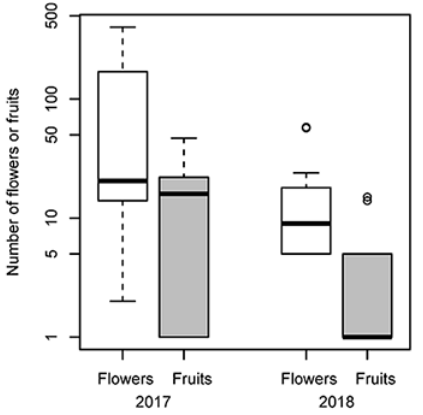
Fig. 4 Box-plots showing the number of flow- ers and developed fruits in 2017 and 2018 in the Rhododendron ferrugineum population in the Karkonosze Mts. The y axis is log-scaled, hori- zontal bar shows the median, boxes represent the range between the first and third quartile, whiskers represent observations in nonoutlier range, and dots represent